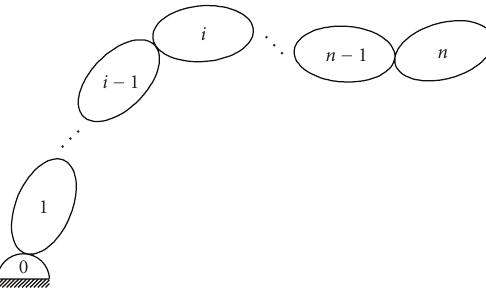
Figure 1: The analyzed multibody